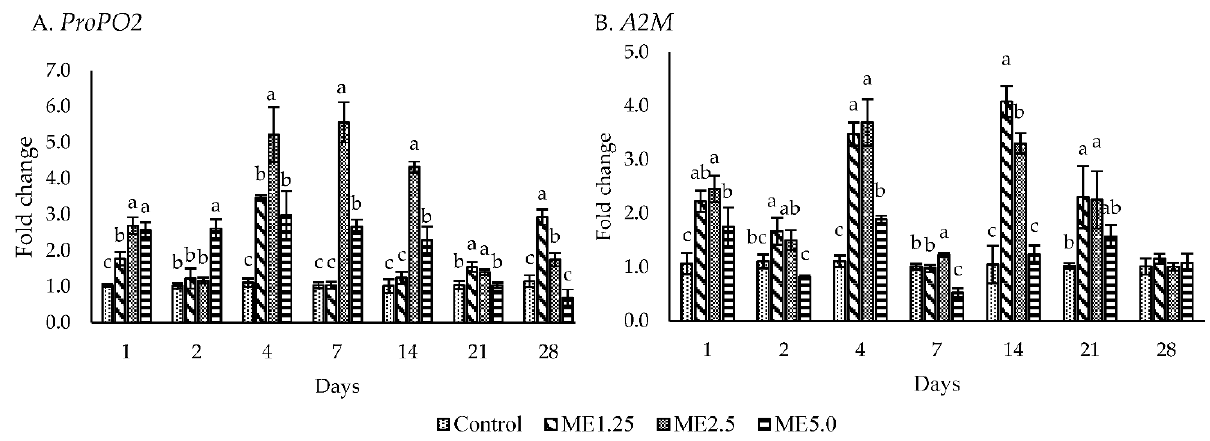
Figure 3. ProPO activating system. The effect of different concentrations of moringa extract in diet (control, ME1.25, ME2.5, and ME5.0) on the expression of ProPO2 and A2M in the hemocytes of whiteleg shrimp. The data are expressed as mean ± standard deviation ( n = 3). Bars with different letters at the same time point are significantly different ( p < 0.05).